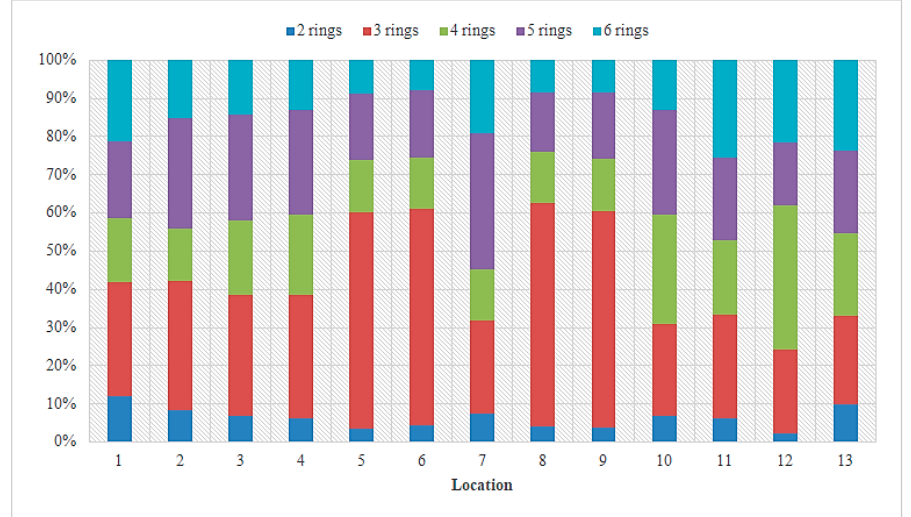
Figure 8. Composition profile of total PAHs in sediment samples from the Sarno